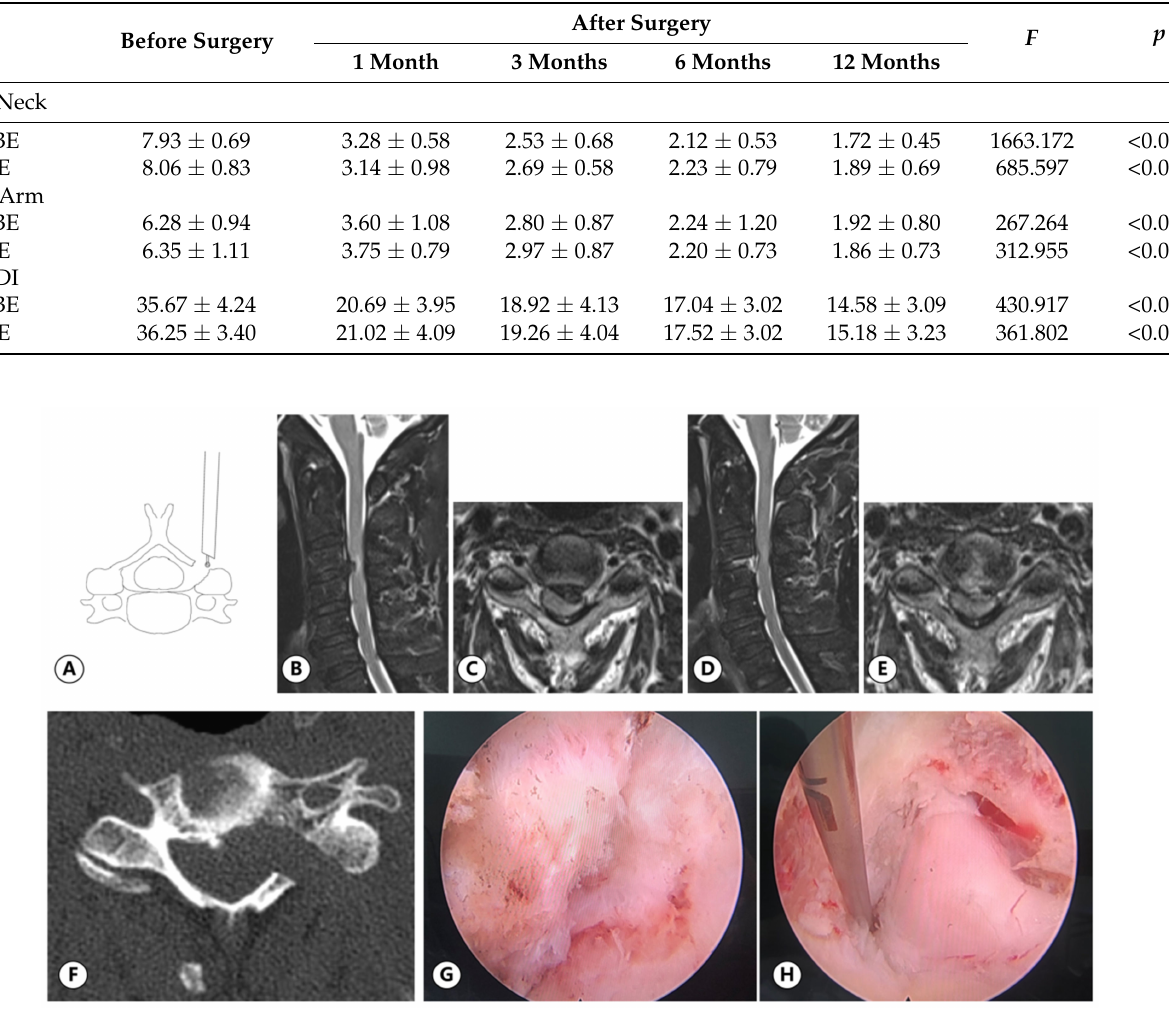
Figure 8. ( A ) Typical case of PE surgery: a 60-year-old male with right limb numbness and unstable walking for 2 weeks. PE operation diagram. ( B , C ) The preoperative MRI images. ( D , E ) The post- operative MRI images. ( F ) The postoperative CT image revealed the range of bony decompression. ( G ) The V point. ( H ) The nerve root decompression was confirmed.